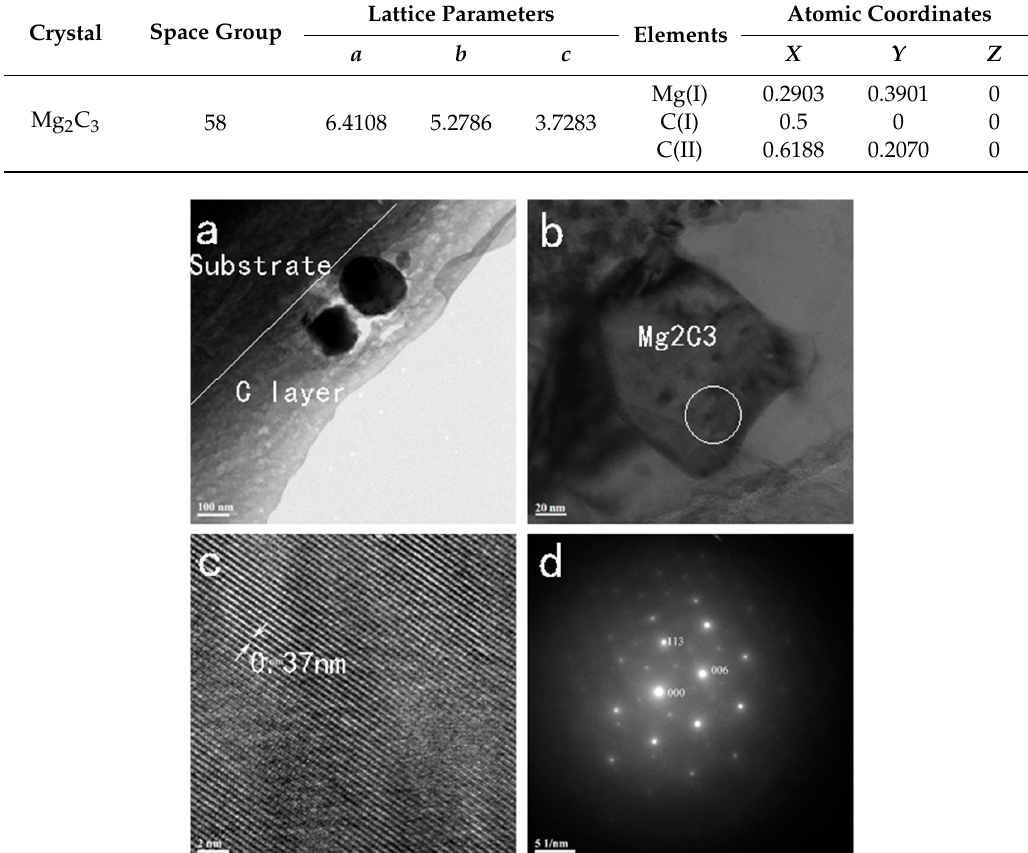
Figure 5. Cross-sectional TEM images of Sample C3: ( a ) surface microstructure, ( b ) compound microstructure, ( c ) high resolution TEM images, and ( d ) diffraction patterns of the compound.